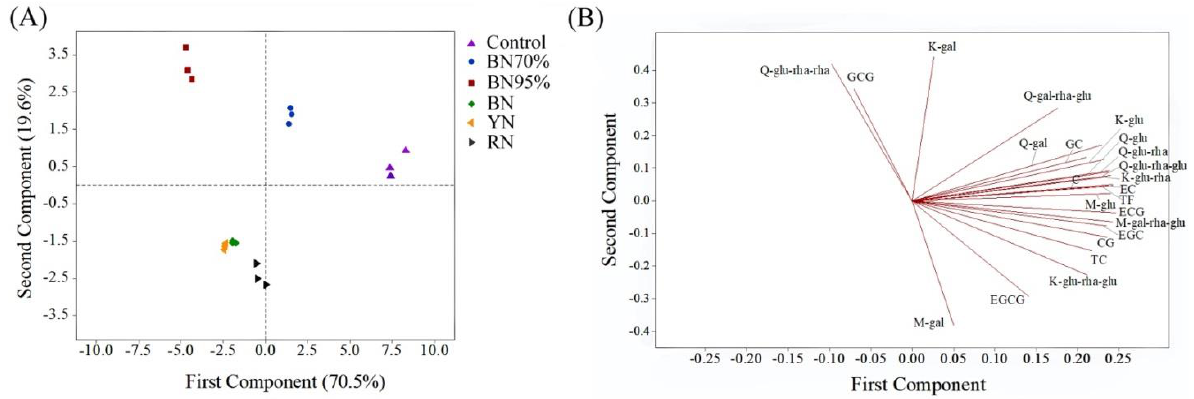
Figure 2. The PCA result of tea leaves under different shade treatments based on the flavonoid compositions. ( A ) score plot; ( B ) loading plot. The number of replicates is equal to 3.